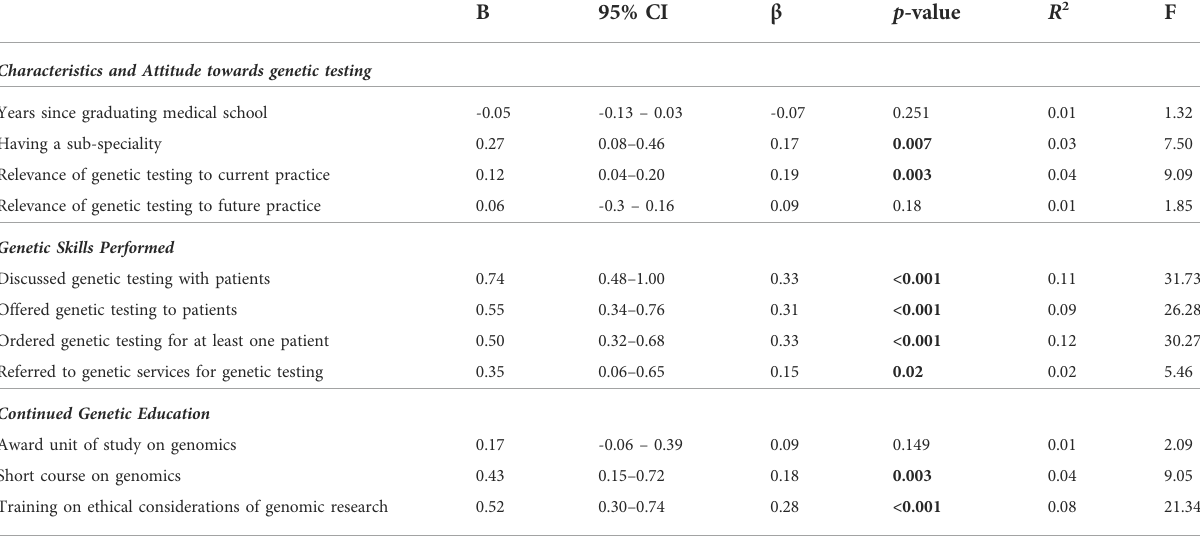
TABLE 5 Simple linear regression assessing independent predictors of dermatologists ’ overall con fi dence in genetic skills. The dependent variable is the overall average con fi dence